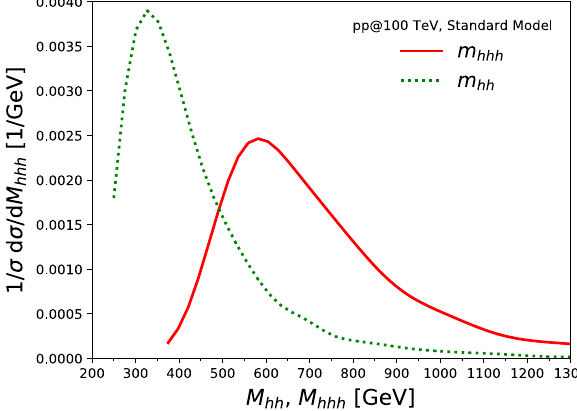
Fig. 1 The invariant mass of any two ( hh , dotted green) or all three ( hhh , solid red) Higgs bosons in triple Higgs production at the FCC-hh at 100 TeV, reconstructed from Monte Carlo truth with no cuts